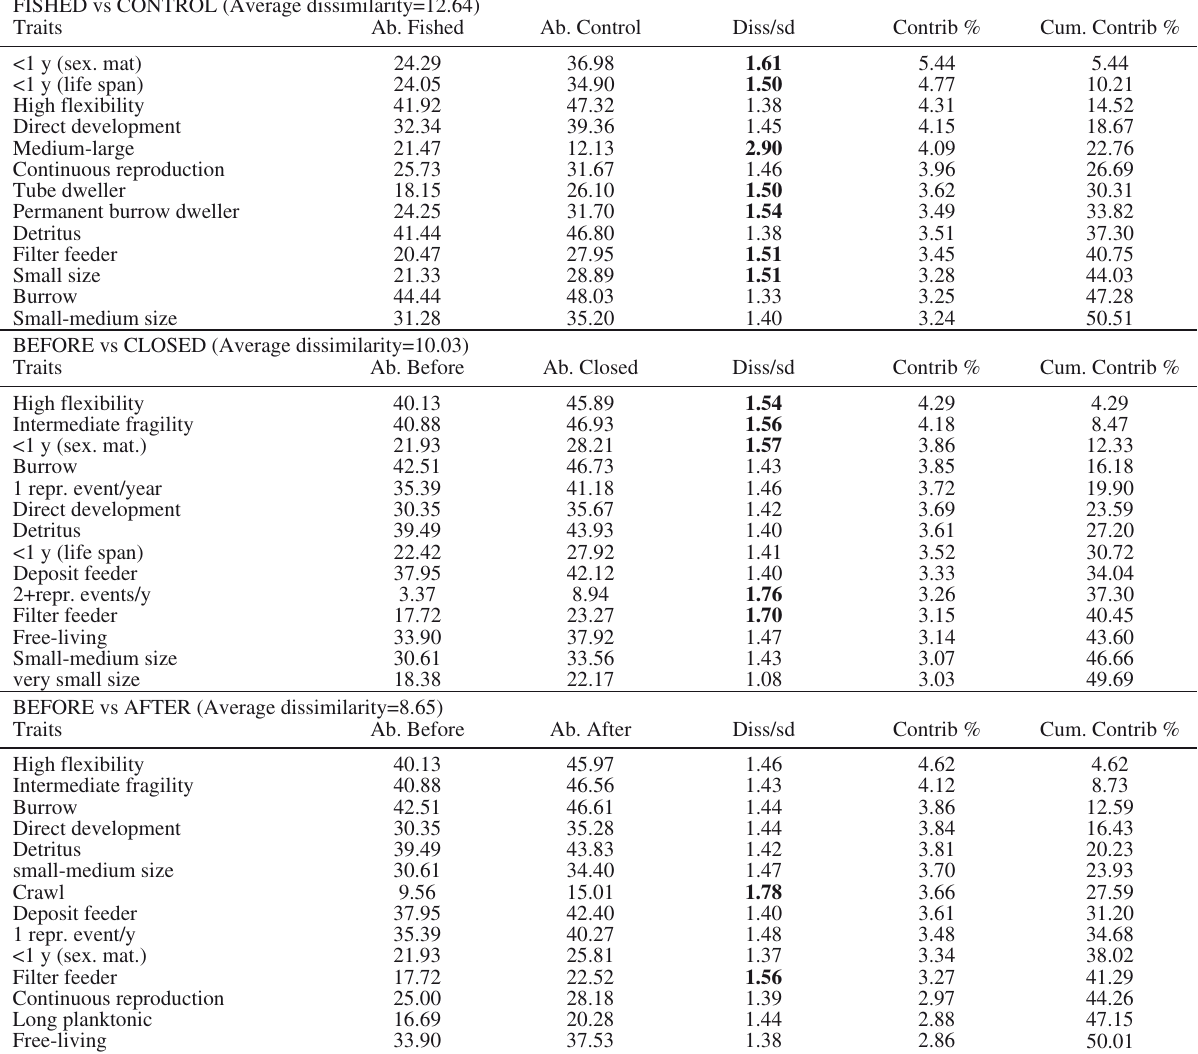
Table 4. – Results of SIMPER analysis for infaunal trait abundance, comparing fished (Ab. Fished) and control (Ab. Control) sites. Fished vs control analysis was based on the whole data set, whereas effort regime analysis was based only on fished site samples. Cut-off to traits list applied at 50% of cumulative contribution to dissimilarity (Cum. Contrib.%); traits with a ratio of dissimilarity to standard deviation (diss/sd) >1.5 are highlighted in bold. FISHED vs CONTROL (Average dissimilarity=12.64)